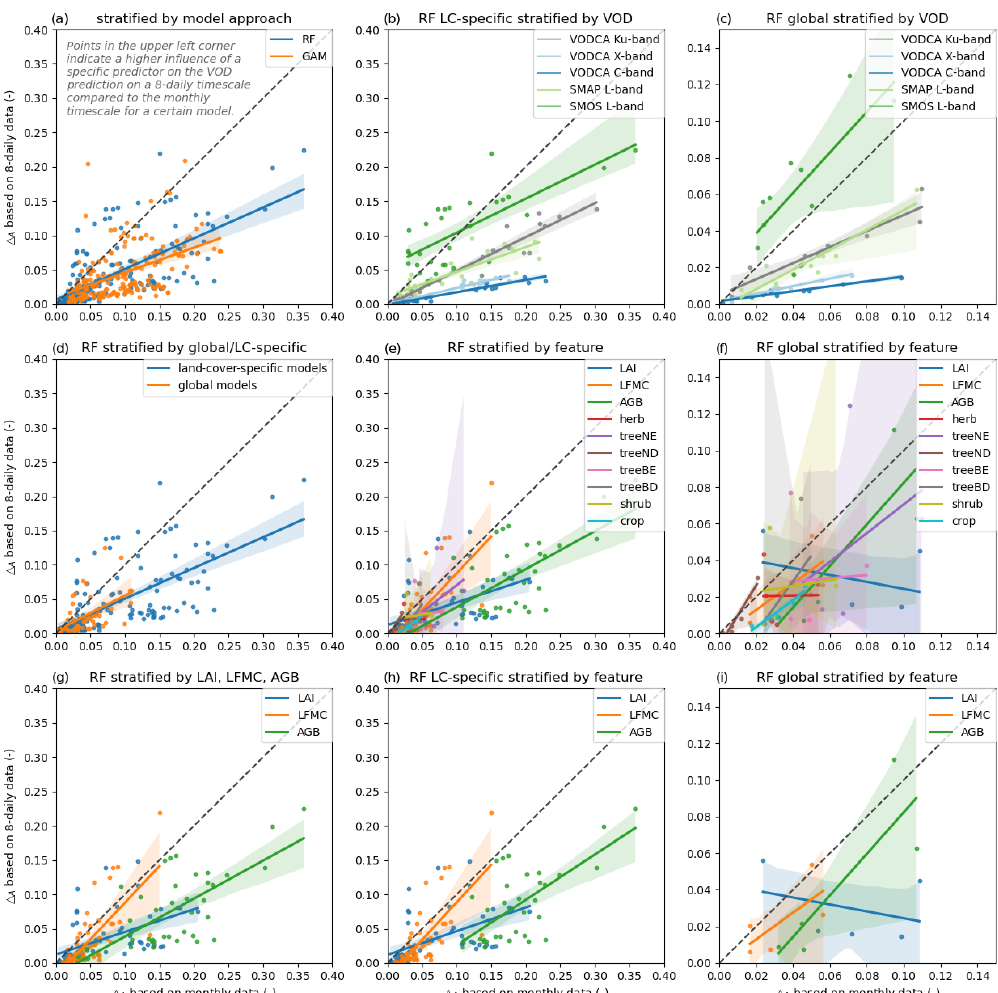
Figure 6. Regression plots of individual ALE amplitude (cid:49) A values on a monthly data basis vs. on an 8-daily data basis. Panel (a) shows the (cid:49) A of ALE curves from GAM and RF, whereby panels (b) to (i) show only (cid:49) A of RF models but which are colourized by different factors: “global” indicates the global models which use also PFT fractions as predictors and “LC-specific” identifies the land-cover-specific models which only use LAI, LFMC, and AGB (for tree cover) as predictors and used data filtered for the specific land cover type. Note that panels (c) , (f) , and (i) are zoomed in compared to the other subplots. Points located in the upper-left corner indicate a higher influence of a specific predictor on the VOD prediction on an 8-daily timescale compared to the monthly timescale for a certain model. Points located on the 1:1 line indicate a constant influence on VOD regardless of the considered timescale. Points located in the lower-right corner indicate a higher influence of a predictor on a monthly